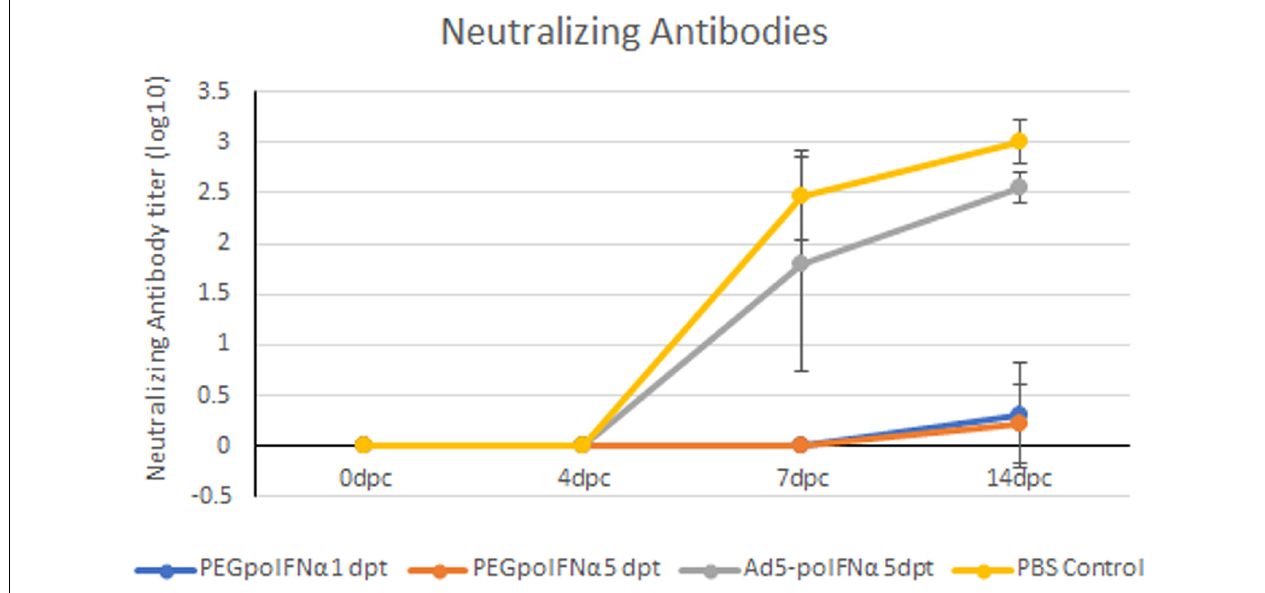
FIGURE 5 | Determination of FMDV neutralizing antibodies. The presence of FMDV neutralizing antibodies was evaluated in sera of animals treated with PEGpoIFN α or with Ad5-poIFN α and challenged after 1 or 5 dpt, by a microtiter neutralization assay on BHK-21 cells. Titers are reported as the log 10 of the reciprocal of the highest dilution of serum that neutralized the virus in 50% of the